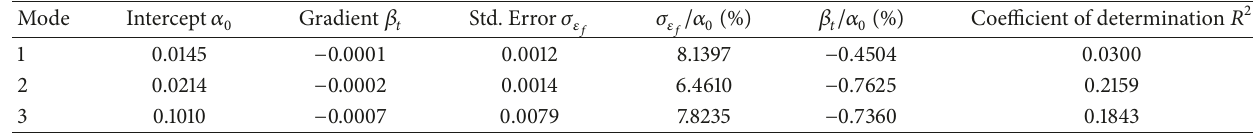
Table 11: Coefficients of linear regression model (damping ratio ∼ temperature) of girder No. 3.